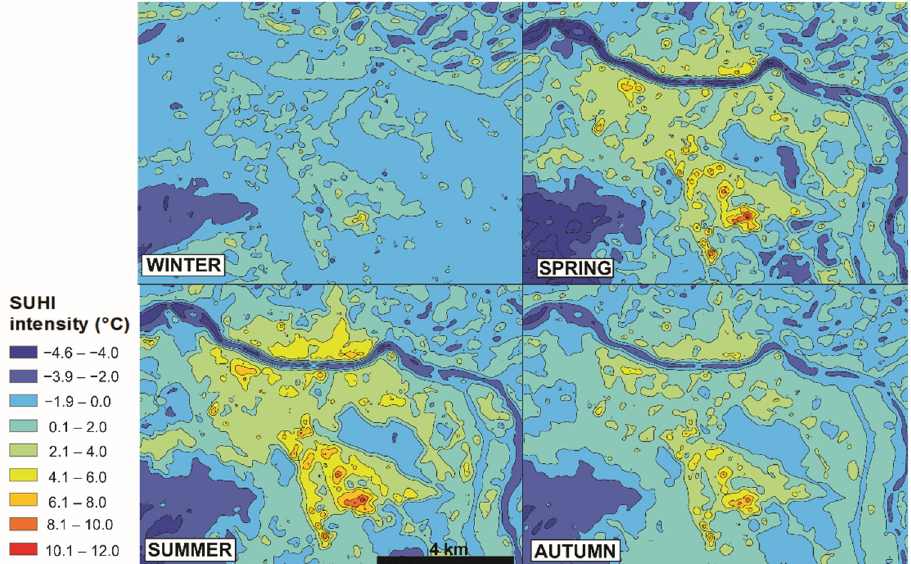
Figure 2. The seasonal SUHI footprint of Maribor.